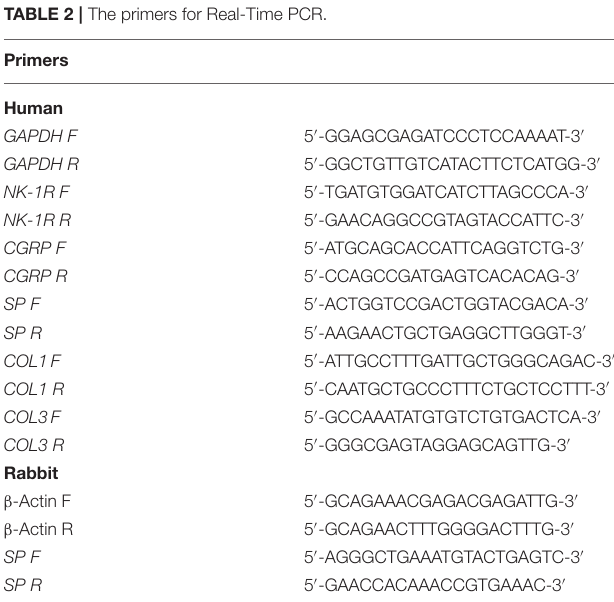
TABLE 2 | The primers for Real-Time